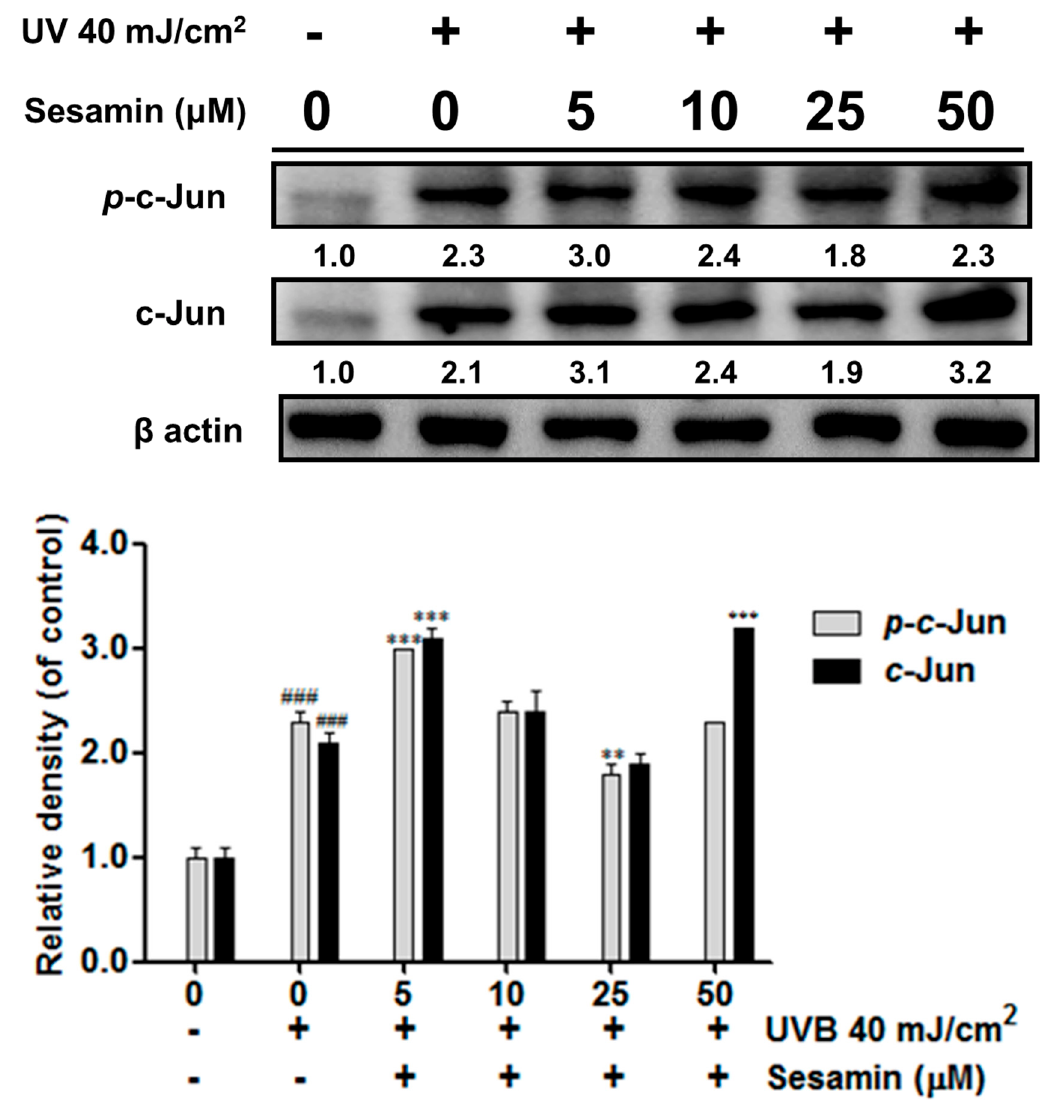
Figure 5. Sesamin on the ameliorated UVB induced AP-1 expression in human skin fibroblasts. ###, p p < 0.001: Significant di ff erence versus non-irradiation group. ** p < 0.01; *** p < 0.001: Significant < 0.001: Significant difference versus non-irradiation group. ** p < 0.01; *** p < 0.001: Significant di ff erence versus non-treatment difference versus non-treatment group.